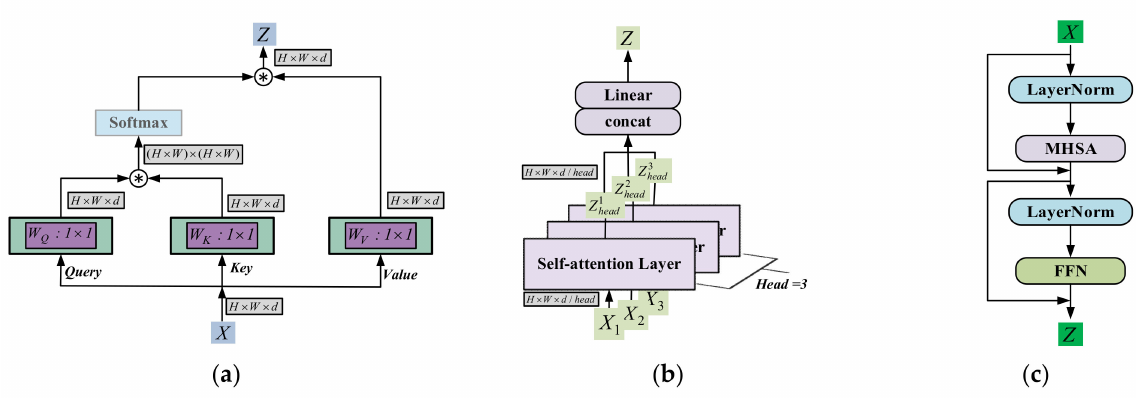
Figure 1. Three key architectures in transformers are depicted schematically. ( a ) Self-Attention; ( b ) Multi-head Self-Attention; ( c ) Transformer encoder. Implementing Self-Attention requires defining three key elements. The